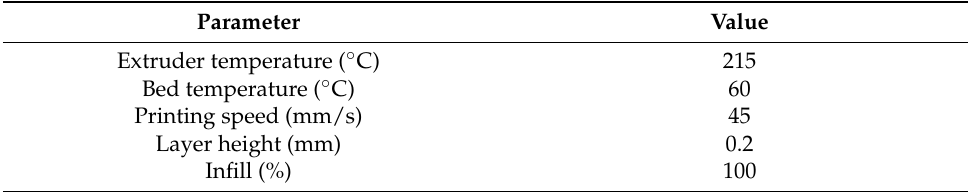
Table 1. FFF printing parameters.